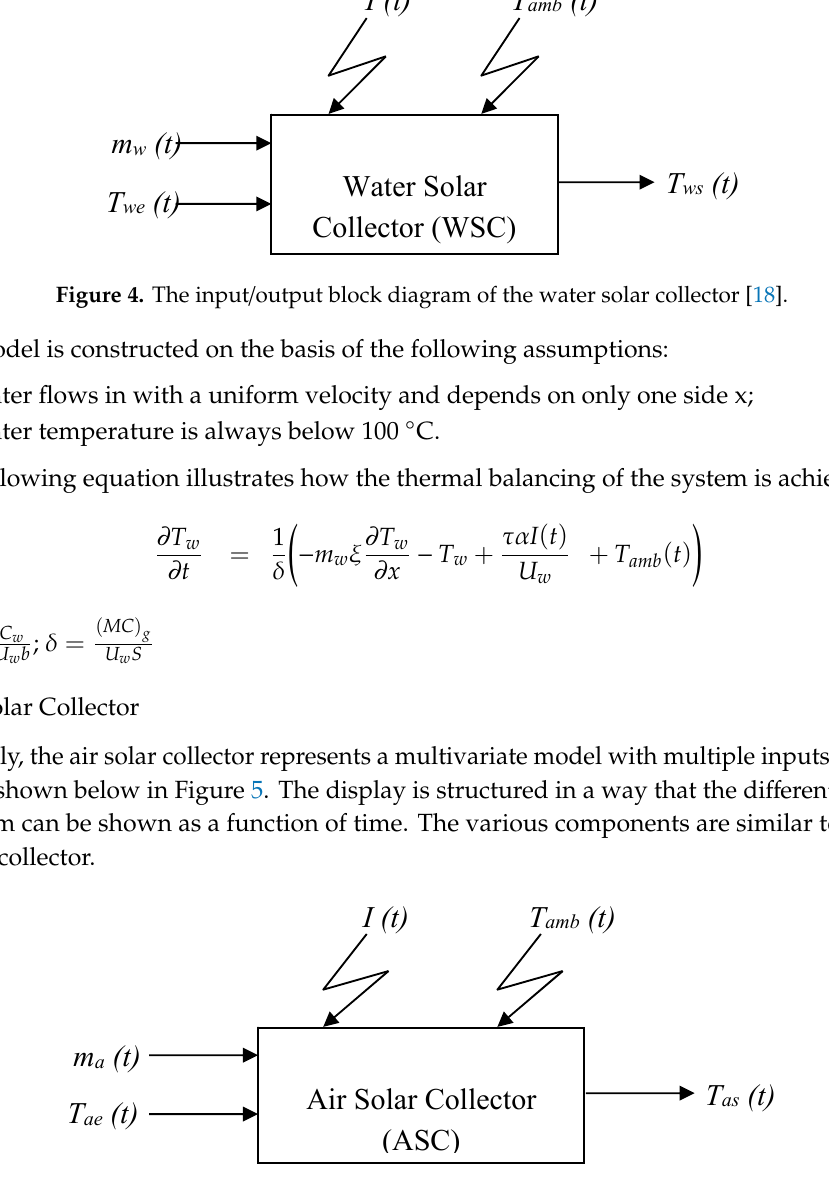
Figure 5. The input/output diagram of the air solar collector [18].